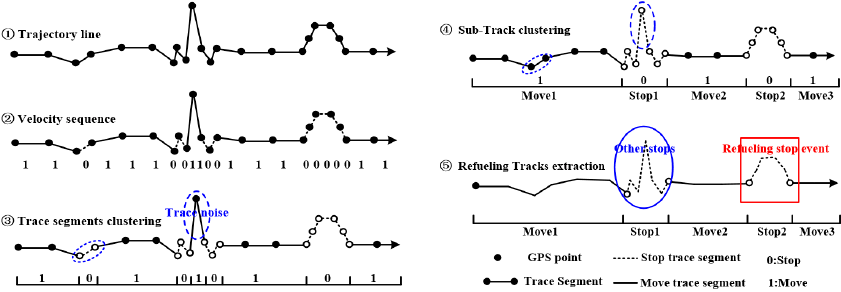
Figure 3. Refueling stop sub-tracks extraction by the Velocity Sequence Linear Clustering (VSLC) algorithm.